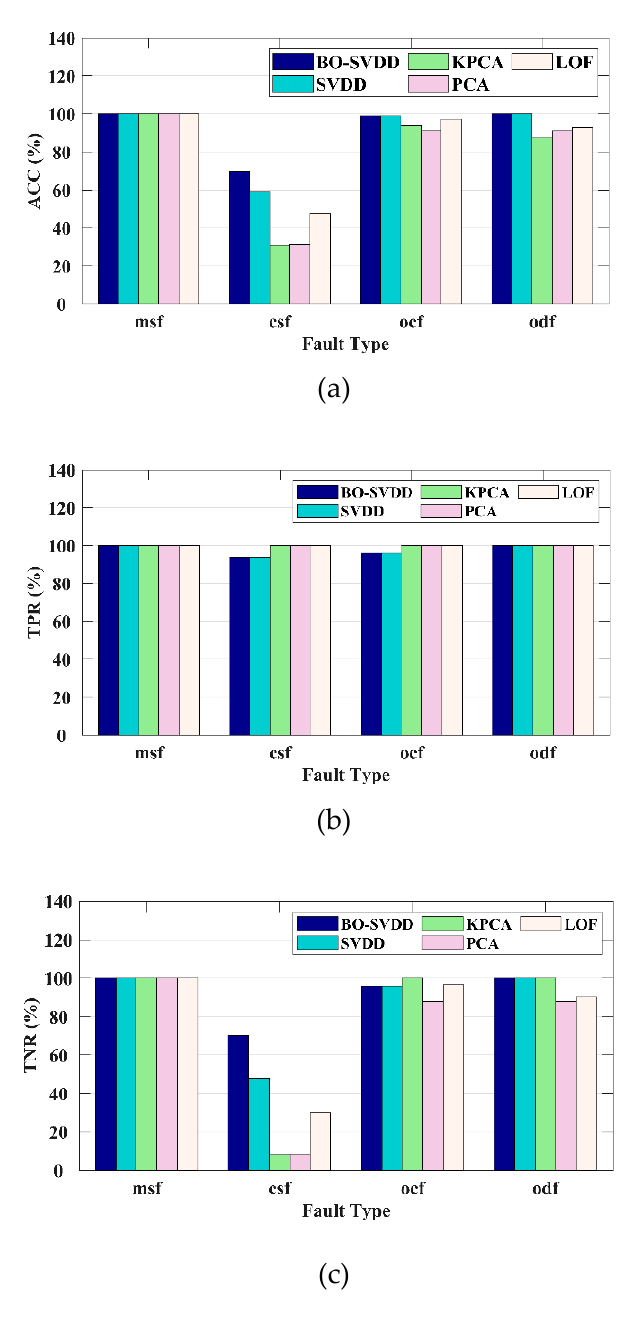
Figure 12. BO-SVDD, SVDD, KPCA, PCA, test results for three evaluation metrics in four test sets (csf, msf, ocf, odf): ( a ) ACC metric; ( b ) TPR metric; and ( c ) TNR metric.